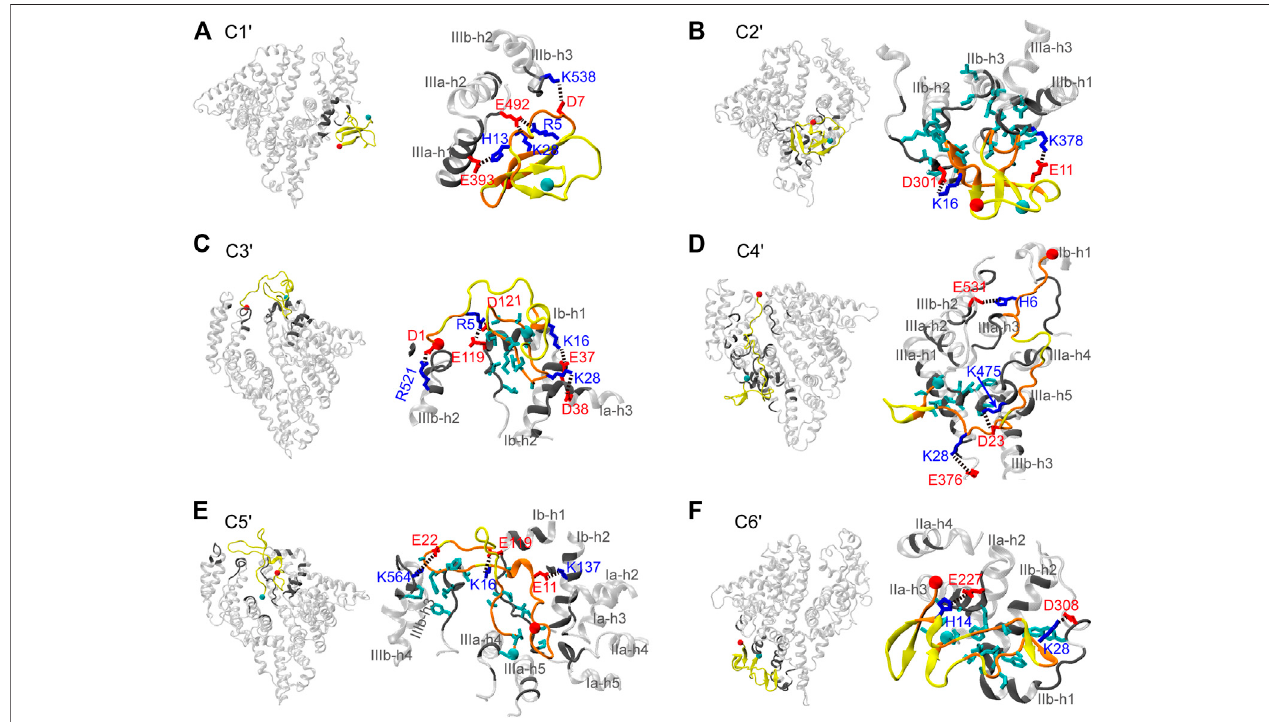
FIGURE6|(A – F) RepresentativestructuresoftheA β 42-HSAcomplexesinthesixmost-populatedclusters.Ineachpanel,anoverviewofthecomplexisshownon the left and an enlarged view of the binding surface is shown on the right. HSA is transparent and residues in contact with A β 42 are highlighted in gray. A β 42 is in yellow and residues in contact with HSA are in orange. Side chains are colored according to the residue types (acidic: red; basic: blue; hydrophobic: cyan). The C α atoms of residues D1 and A42 are indicated by red and cyan balls, respectively.